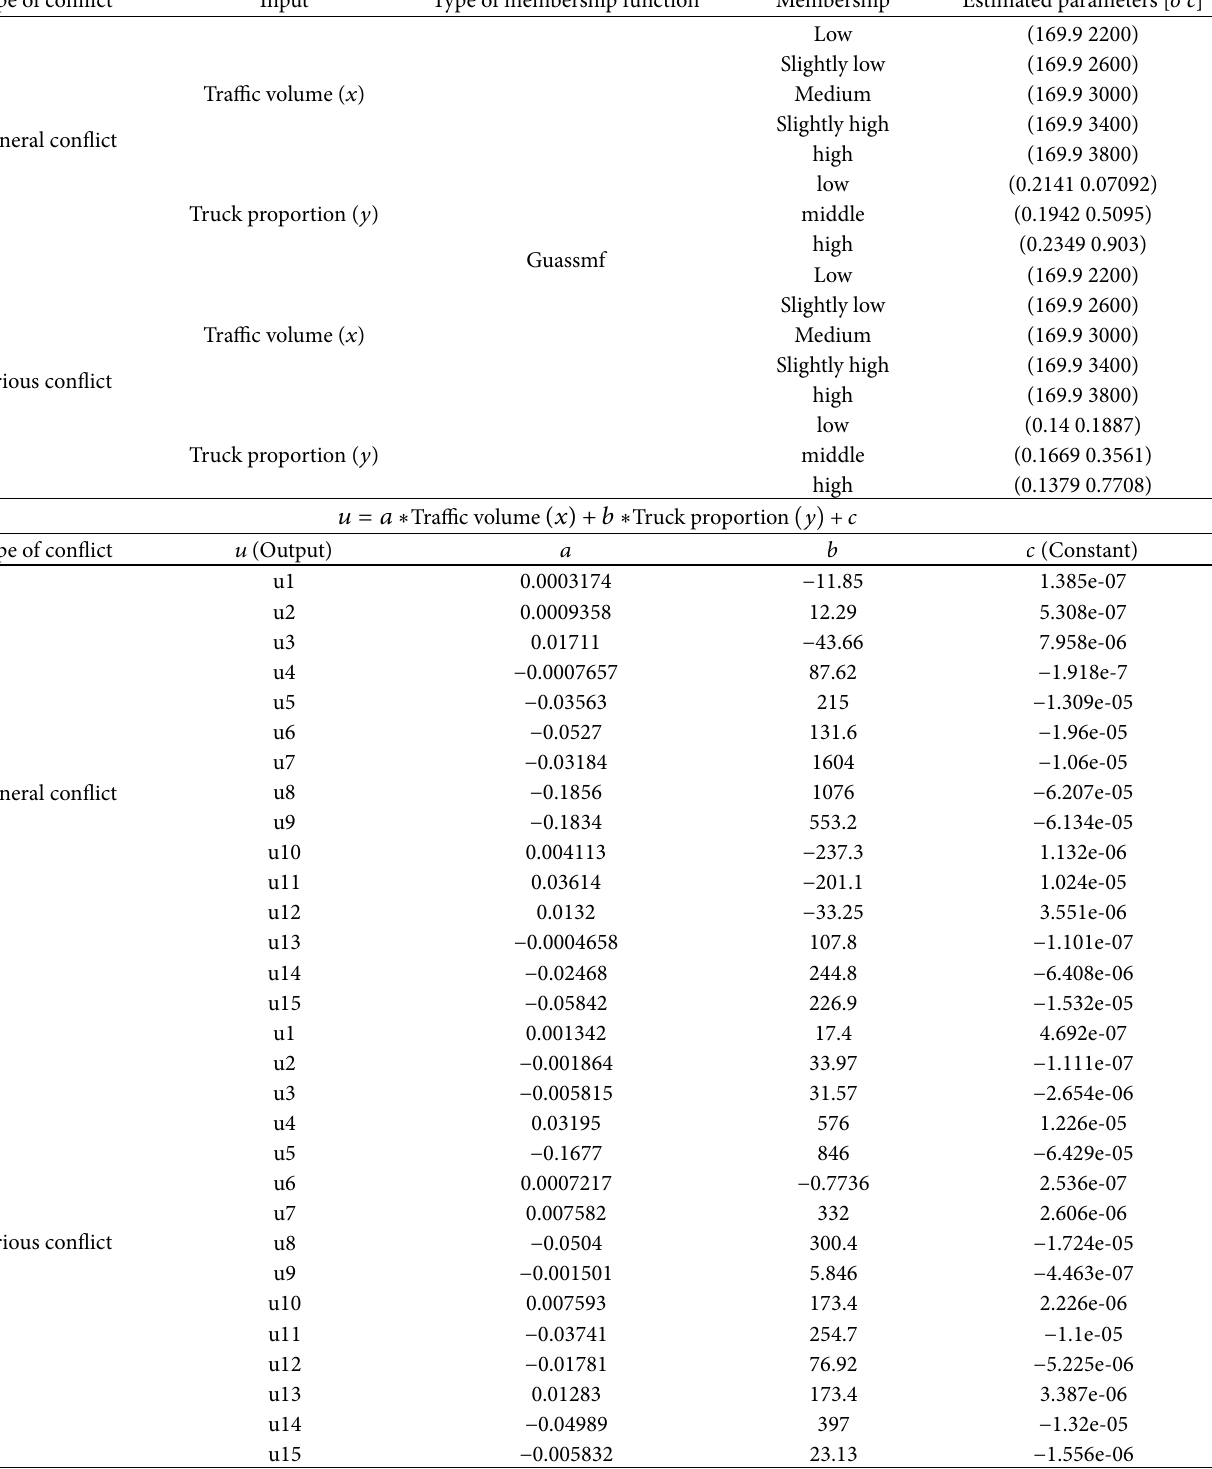
Table 6: The estimated input membership parameters and the estimated consequent parameters of sugeno linear function. Type of conflict